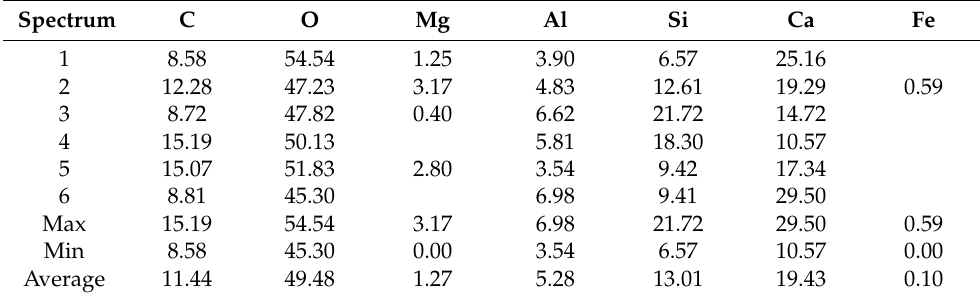
Table 4. Element mass percentage content of the carbonation layer in group WB